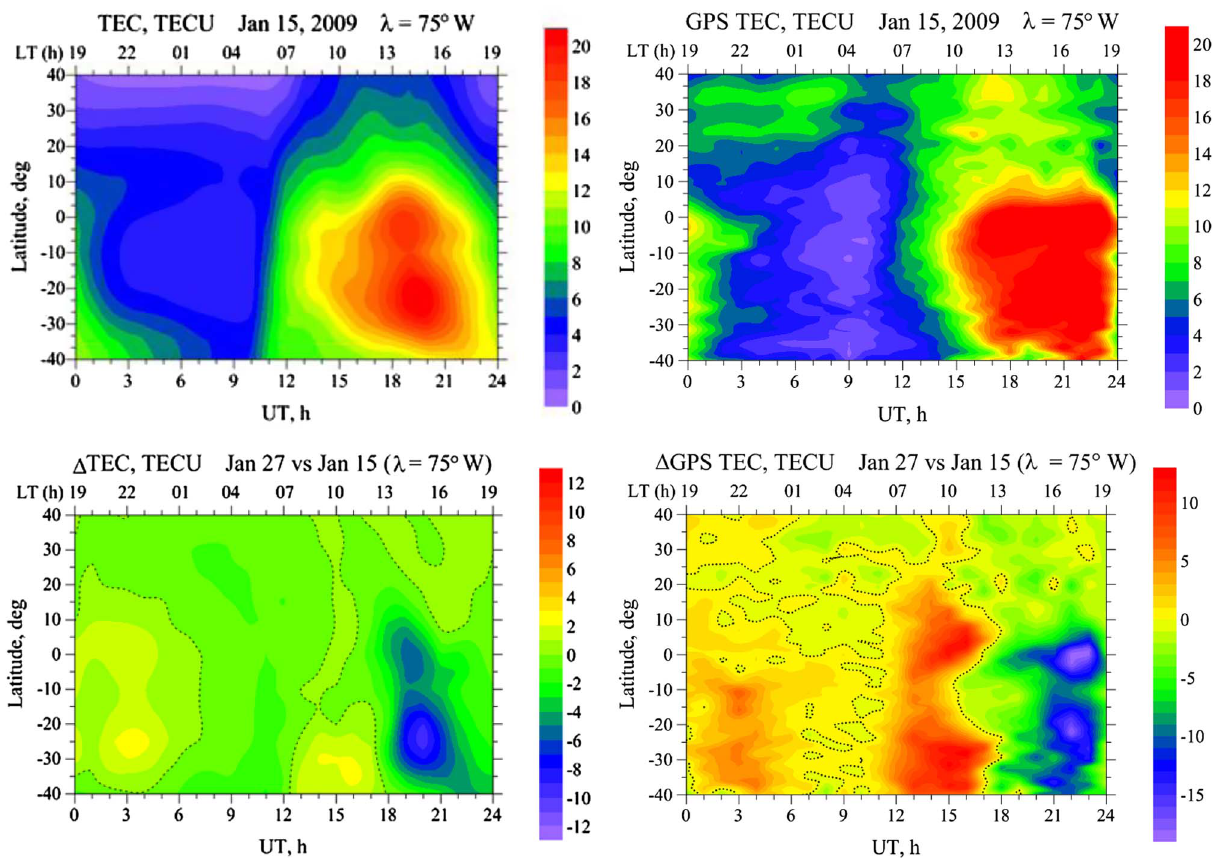
Fig. 3. Diurnal variation of the TEC latitudinal pro fi le on 15 January 2009 (top panel), and TEC disturbances on 27 (bottom panel) January 2009: (left) EAGLE model results vs. (right) GPS TEC